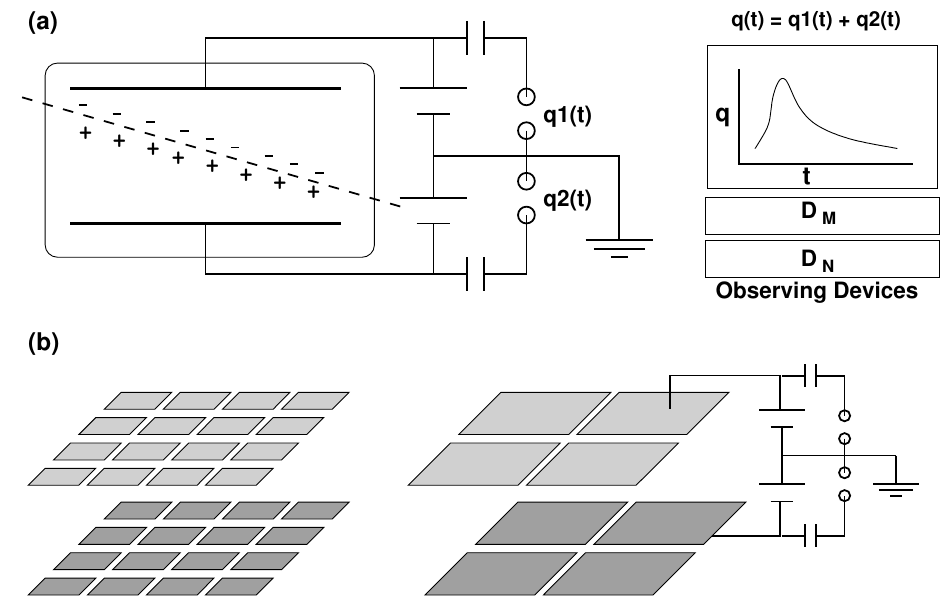
Figure 3. Ionization chamber. ( a ) The figure shows a schematic of an idealized experimental setup. A heavy ion passing between the two parallel plates (electrodes), knocks out electrons from the argon atoms. The electric potential difference between the plates accelerates the electrons towards the anode. The positively charged ions move slowly towards the other electrode. q 1 ( t ) and q 2 ( t ) designate rate of charge flow (current) on respective plates as a function of time. The plot on the right shows one possible profile of sum of the currents, which is the net current between the plates. D M and D N are threshold current detectors. The setup is idealized only in the sense of a precision instrument that can measure small currents (about nanoamps) over small times (micro-seconds). An alpha particle with 1.5 MeV/nucleon energy, argon gas at STP, and a potential difference of about 250 volts across a plate separation of 10 cm can give rise to such values. ( b ) The electrodes are divided into smaller parts to form a grid. Temporal current profiles are recorded at each of the electrodes in a pair. The perpendicular electric field between the two parallel plates bends the charged particles towards the closest points on the respective